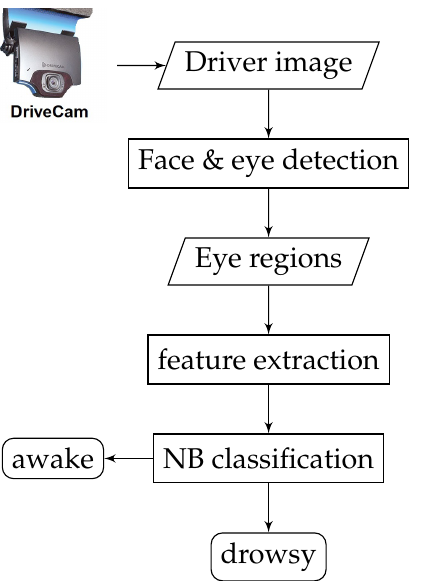
Figure 1. A functional block diagram of the proposed framework for driver drowsiness